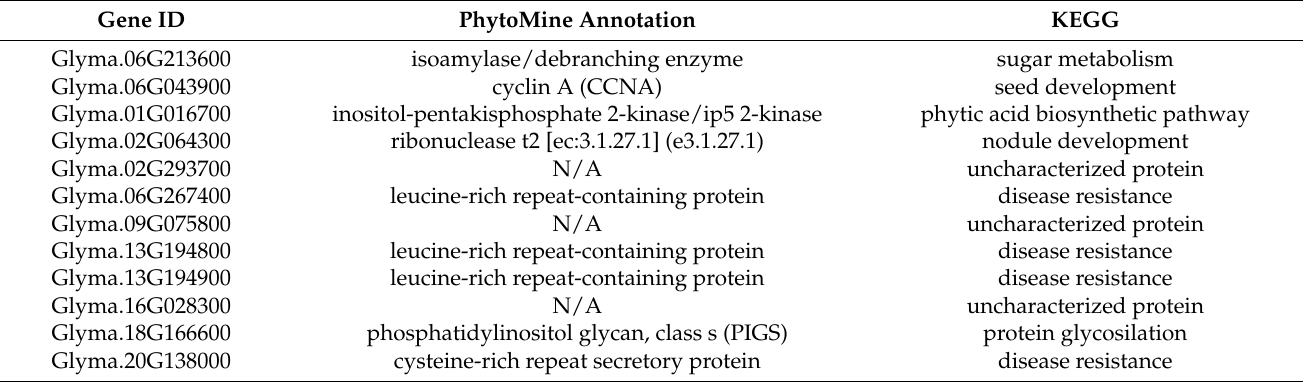
Table 1. Genes that are exclusively expressed in the black seed coat cultivar BRSMG 715A of soybeans. Gene ID